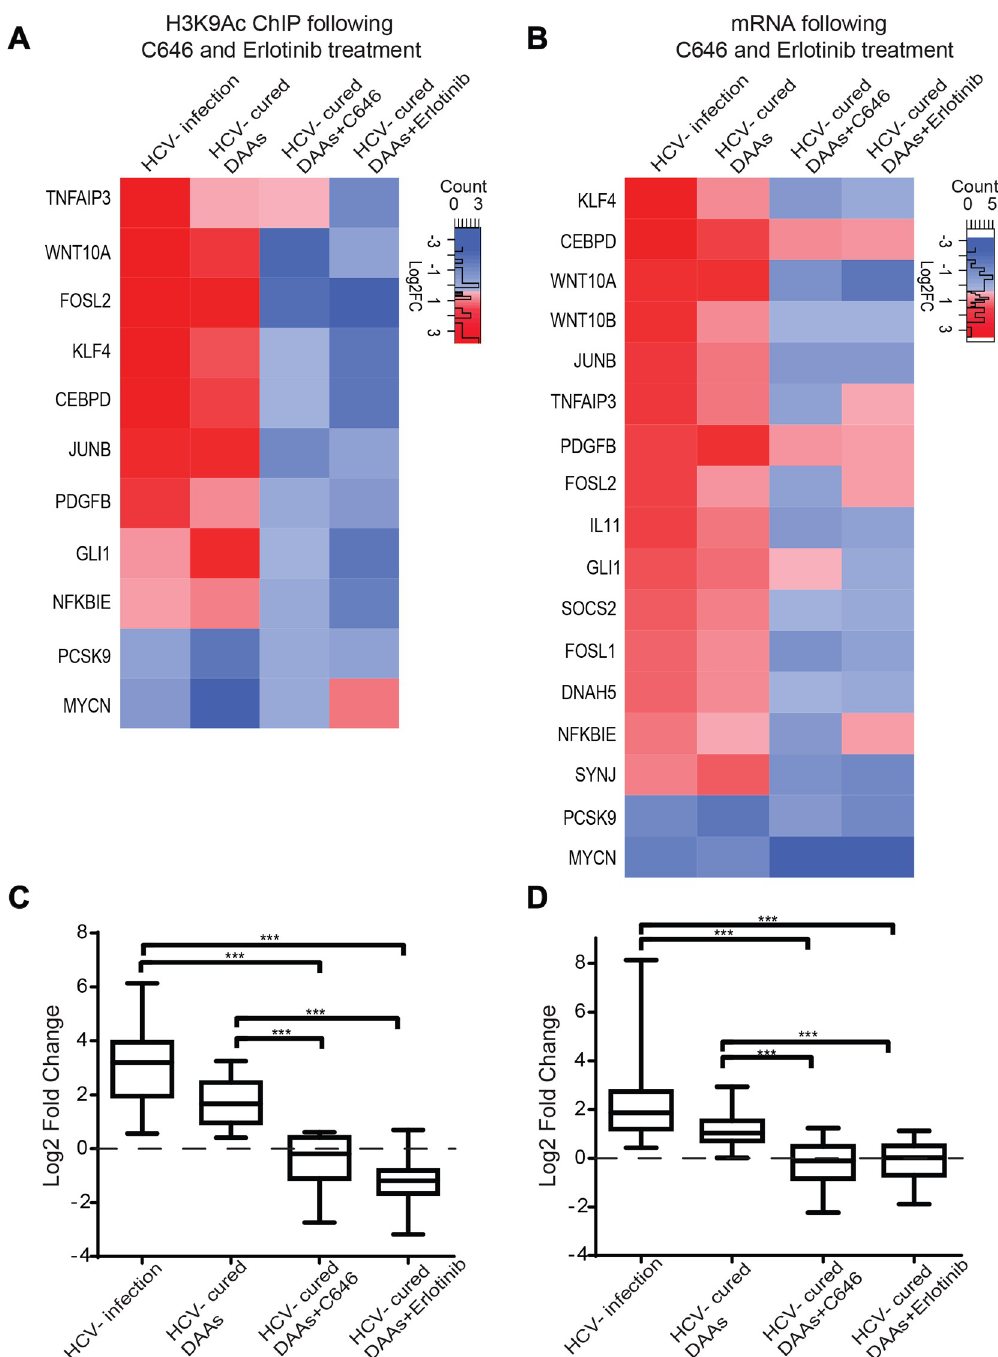
Fig 6. The HCV-induced epigenetic signature is reverted following treatment with specific inhibitors. (A) Cured and control cells (non-infected Huh7.5 cells also treated with DAAs) were treated with 10 μ M C646 or 1 μ M of EGFR inhibitor erlotinib for 1 week. Following treatment, H3K9Ac ChIP was performed on C646/erlotinib treated cured cells (normalized to control DAAs treated and then C646/erlotinib treated cells) compared to DAAs treated cells in the absence of C646/erlotinib (normalized to control DAAs treated cells), and to HCV infected cells (normalized to non-infected cells). The H3K9Ac level was quantified by qPCR with primers for specific genes. Values were normalized relative to qPCR for these genes following ChIP with normal Rabbit IgG Ab as control. The means ± SD of Log2 fold change values from three biological replicates are presented as a heatmap. (B) Cured and control cells were treated with 10 μ M C646 or 1 μ M erlotinib for 1 week as